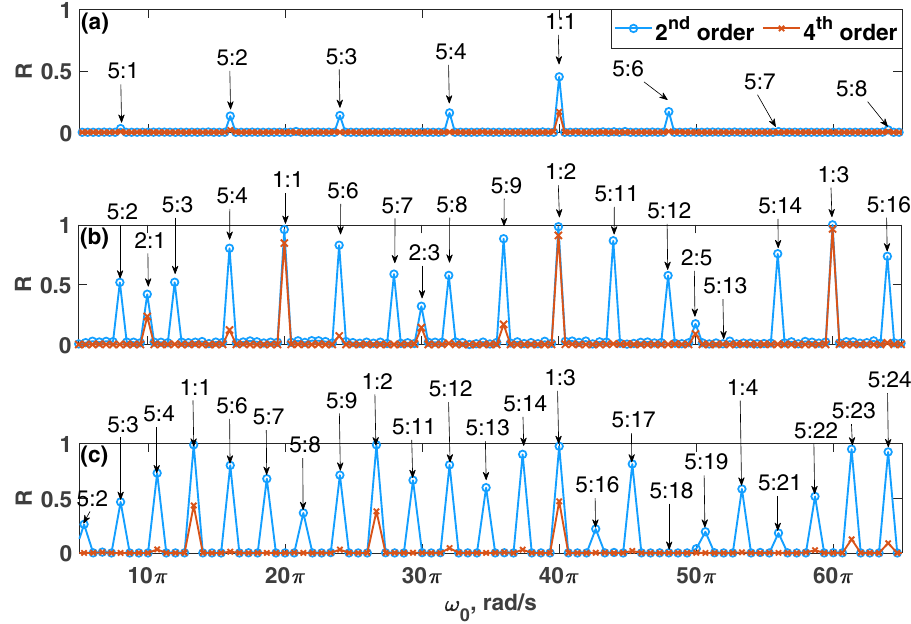
Figure 3. Comparison of the reservoir’s computing performance, R , on the choice of the pseudo-period, T p , and the natural frequency, ω 0 using 2nd and 4th order parity tasks. ( a ) T p = 0.05 seconds, ( b ) T p = 0.1 seconds, and ( c ) T p = 0.15 seconds. Different ratios of the natural period and pseudo-period (e.g., and the ratios are depicted for peaks in the information metric. ω 0 = � = 50 π rad/s is the resonance case. Parameters were set such that: µ = 5 , A = 0.5 , � = 50 π rad/s, N = 1000 nodes, φ = π/ 3 rad, σ = 15 , β = 1.0